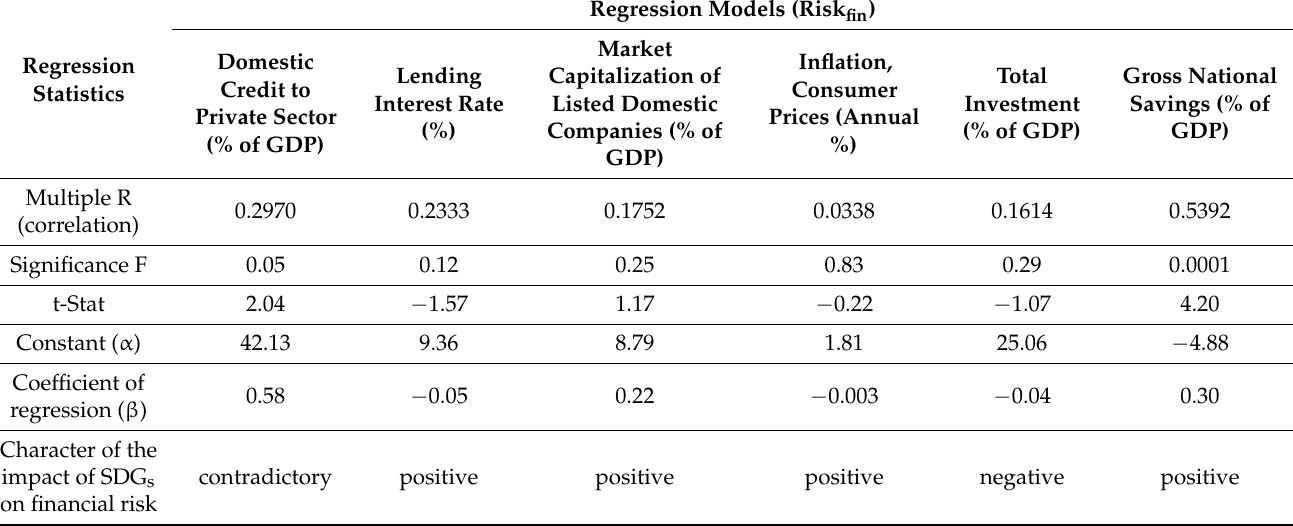
Table 6. Results of the regression